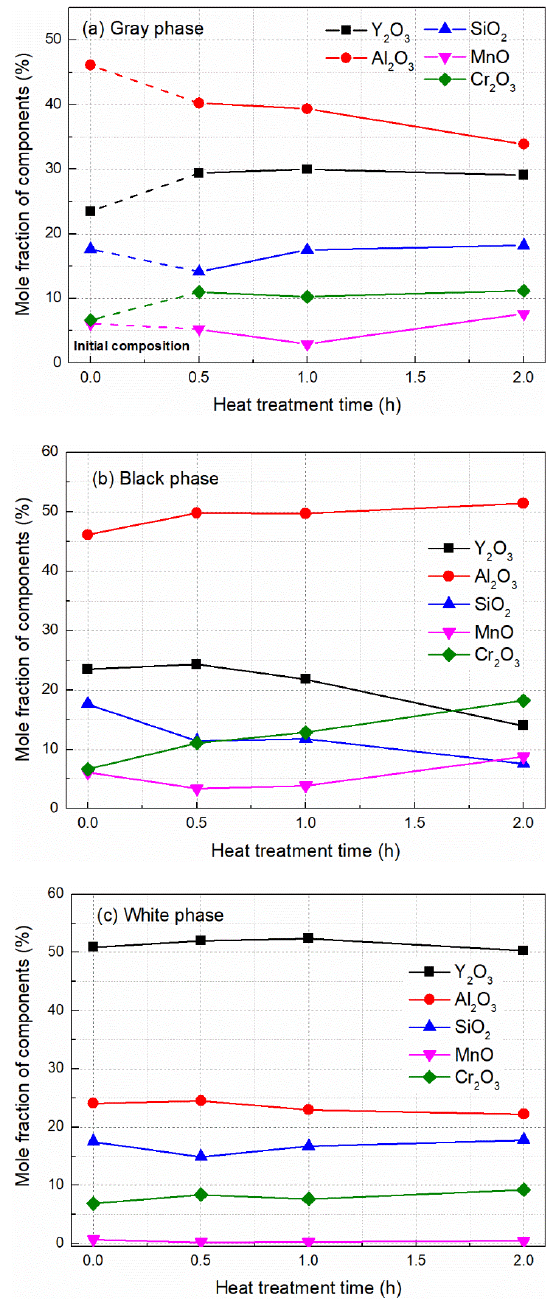
Figure 10. Change in composition of oxide inclusions in steel #2 during heating. gray phase ( a ), black phase ( b ), and white phase ( c ).